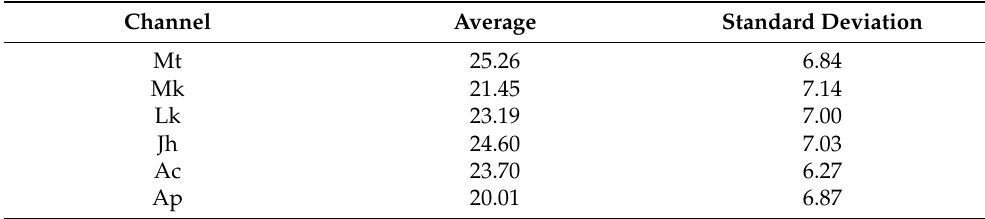
Table 5. Average value and standard deviation of Γ dB , ex (dB) in the indicated Greek